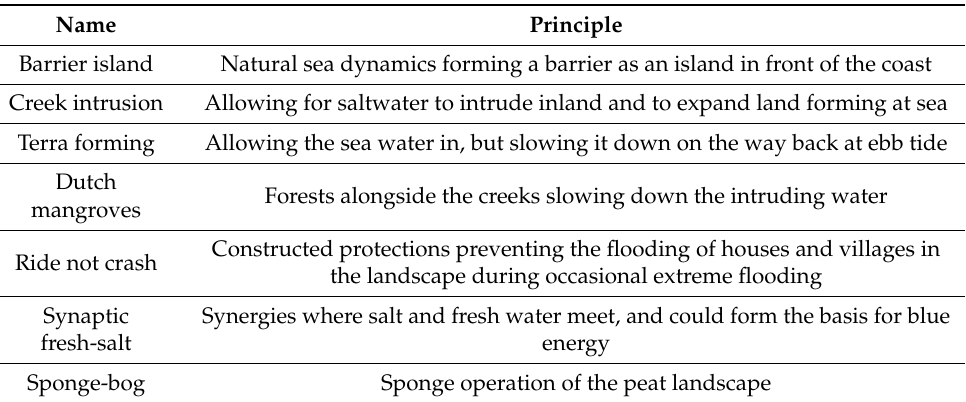
Figure 9. From separated fresh and saltwater systems towards joint and merging systems. Table 1. Lines of protection forming the emergent